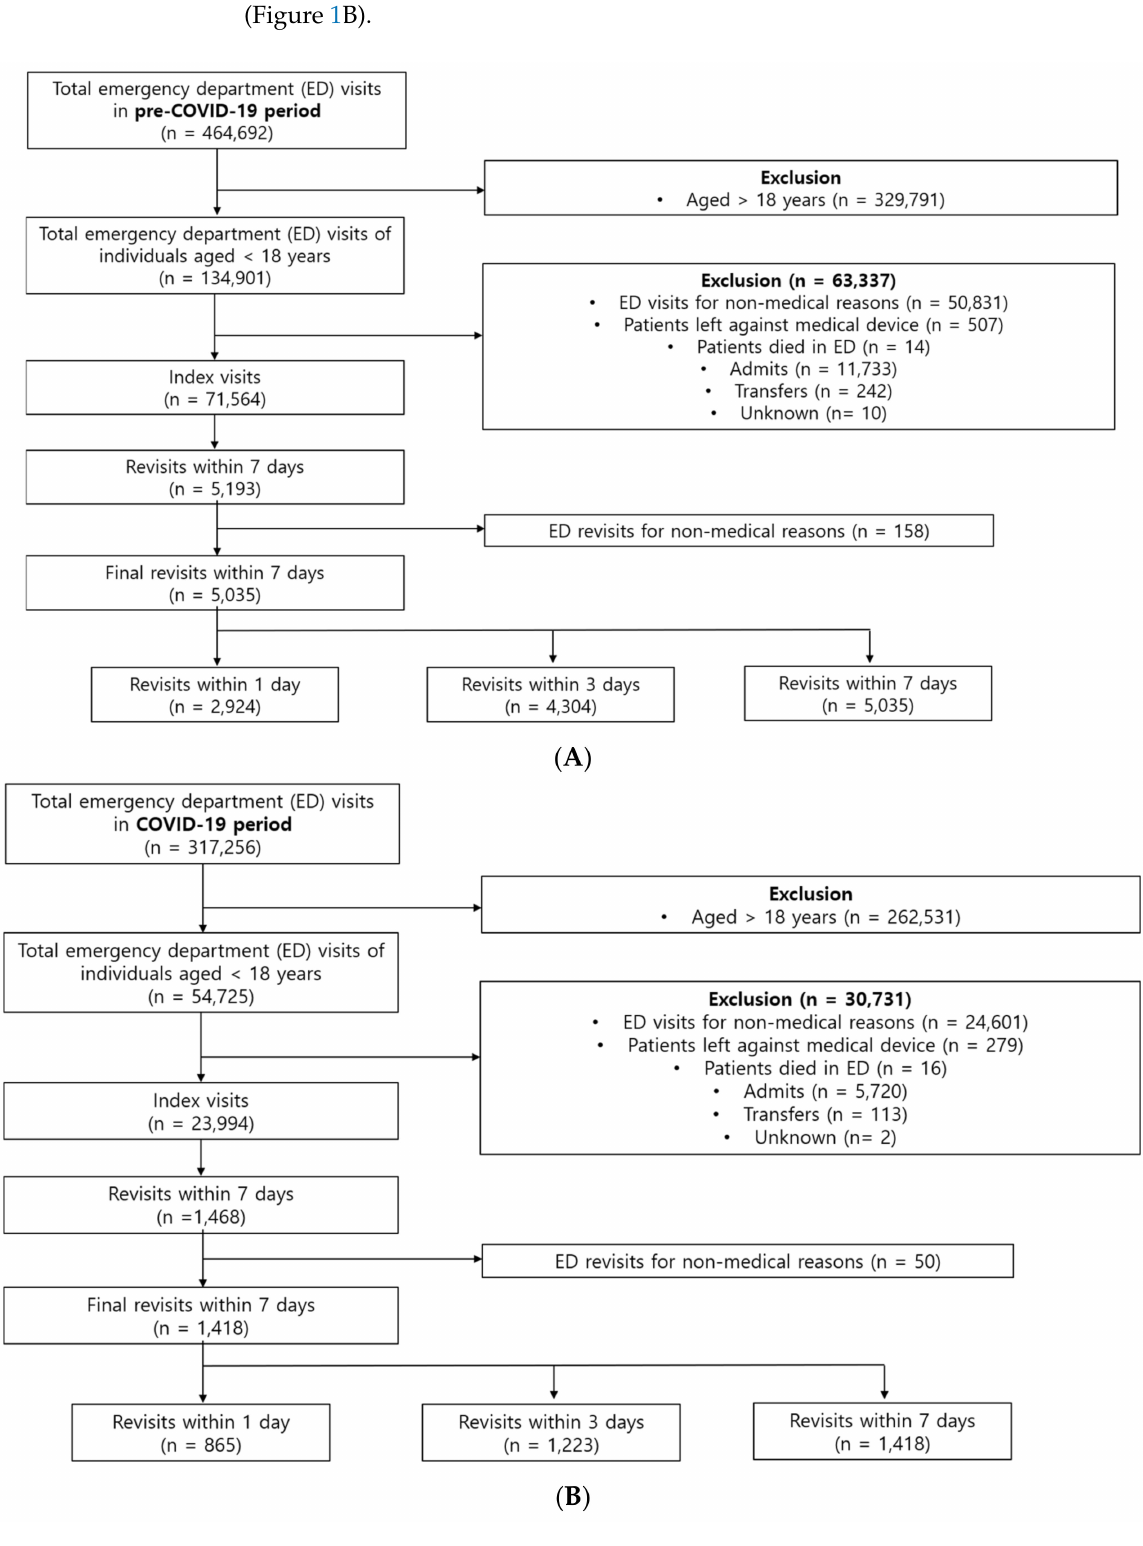
Figure 1. Flow chart of patients enrolled in the pre-COVID-19 period ( A ) and in the COVID-19 period ( B